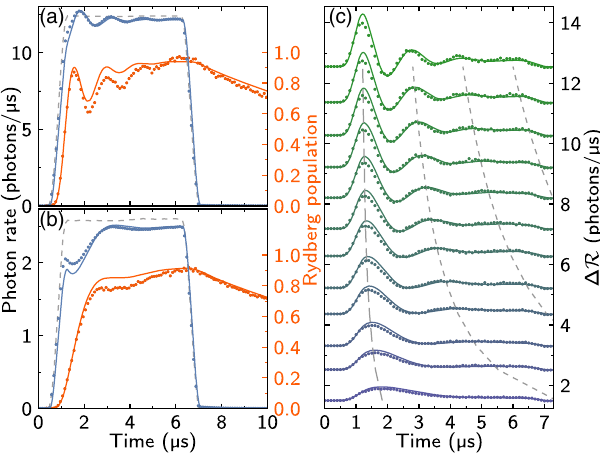
FIG. 2. Time evolution of the photon signal and Rydberg population. (a,b) Time traces of the outgoing probe photon rate (blue points) and Rydberg population (orange points) for input 12 . 4 μ s − 1 pulses (dashed gray line) with peak photon rates R in ¼ 2 . 6 μ s − 1 (b), corresponding to a mean number ¯ N (a) and R in ¼ ph of 71.6 and 15.1 photons in the pulse. The Rabi oscillation of the single superatom is visible both in the excited-state population and in the modulation of the transmitted probe light. Solid lines are fits to the data using our model. (c) Difference signal Δ R ð t Þ between the incoming and outgoing pulses (dots) for different input photon rates R . Each data set is vertically shifted by the in corresponding R . Solid lines are again the result of fitting the in full data set with our theory model using a single set of fit parameters. Dashed lines indicate the expected positions of the Rabi oscillation peaks based on the fitted parameters, showing the ffiffiffiffiffiffiffi p ¯ N scaling of the Rabi period with 1 = . Error bars in (a) – (c) are ph SEM and are smaller than the data